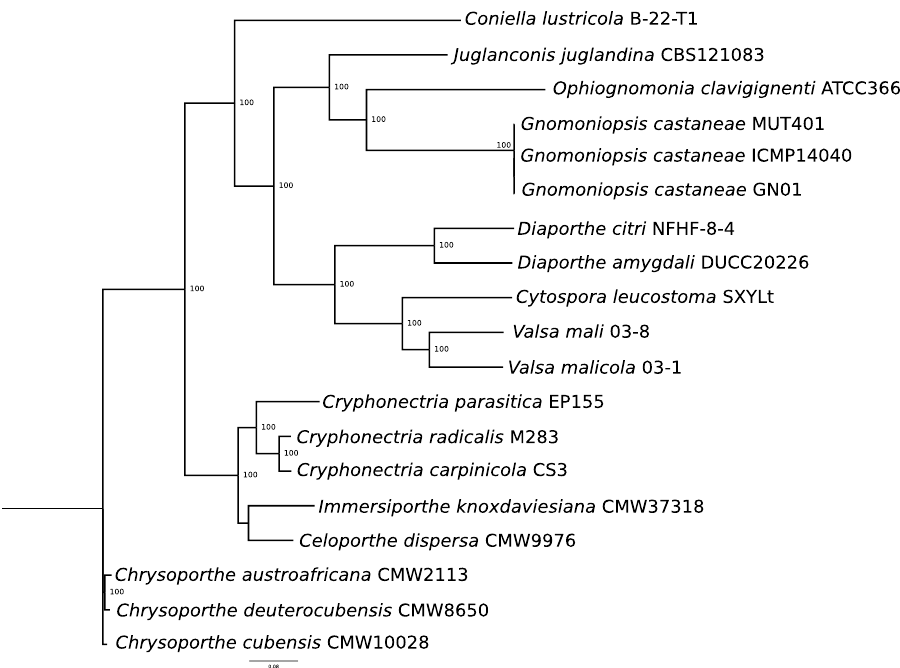
Figure 2. Maximum Likelihood phylogenetic tree based on the 15,041 SNPs in the core genome of the nineteen Diaporthales under comparison. The number of bootstraps is indicated as well.